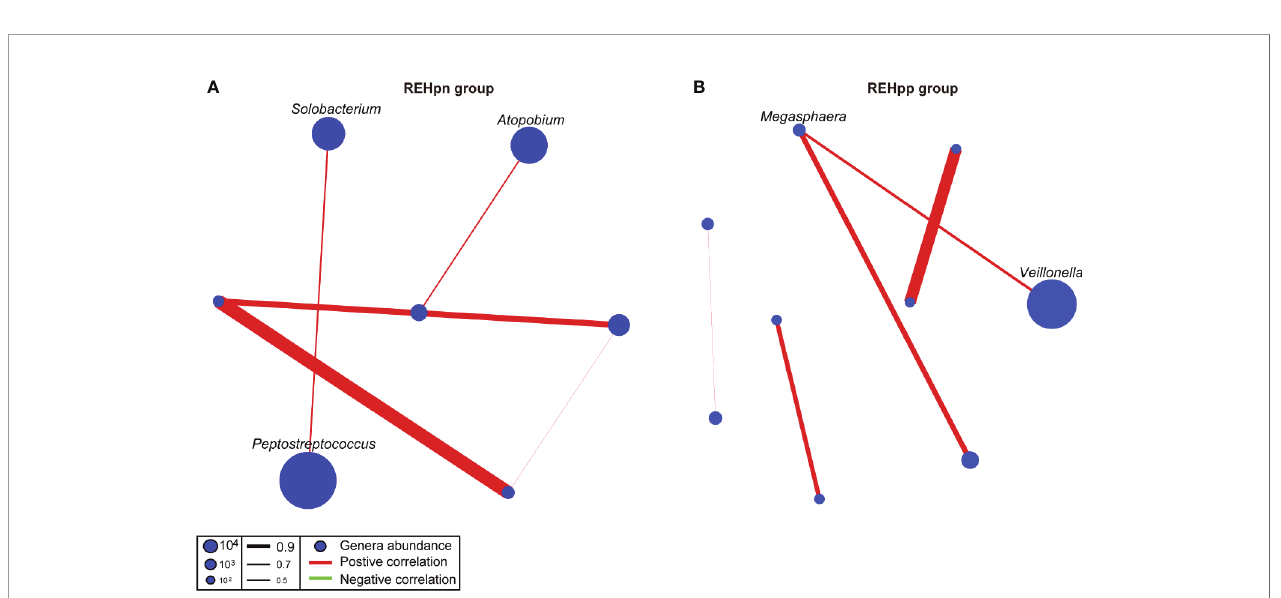
FIGURE 6 | Co-occurrence networks of the REHpn and REHpp groups (A, B) . Each node in the network represents a bacterial genus. The node size represents the mean relative abundance of a genus in the oral microbiota. Red line: positive correlation; green line: negative correlation. Relative thickness of the lines represents the degree of correlation (greater thickness of the edges means a stronger